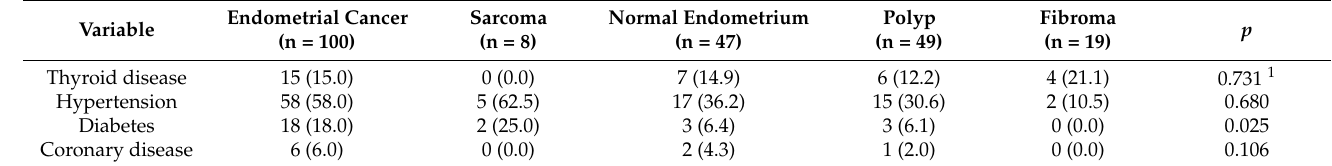
Table 3. Distribution of comorbidities between the analyzed groups.